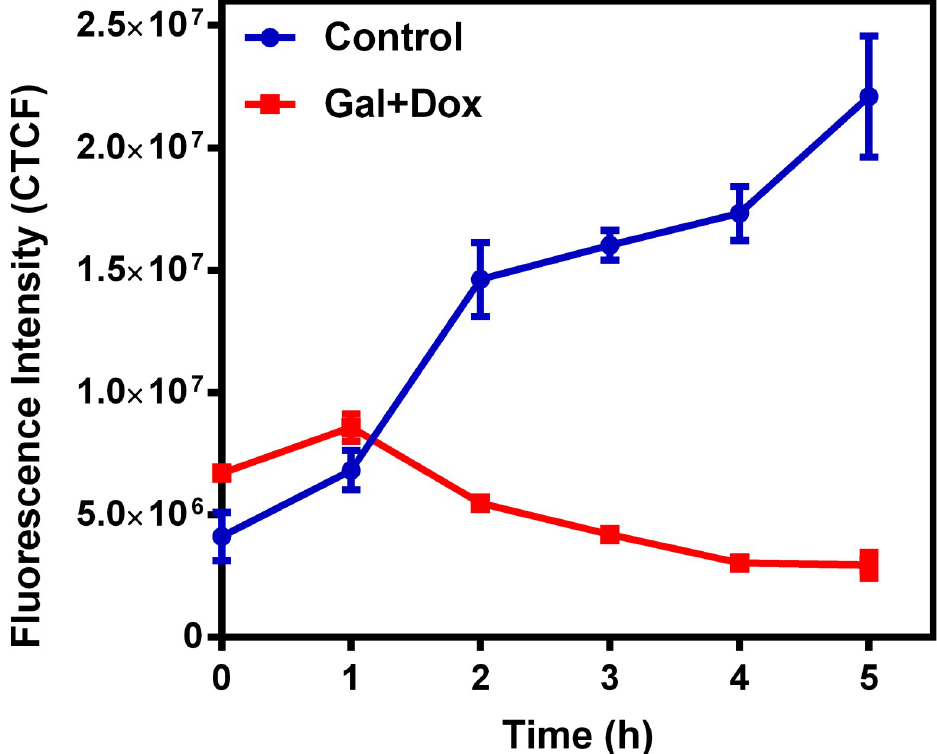
Fig 7. DOX induced cardiomyopathy in rat cardiomyocytes cells. H9c2 cells were treated with DOX (0 and 10 μ g/ mL) for 0–5 h and uptake of Galmydar (20 μ M, 60 min) was determined using fluorescence imaging. Corrected Total Cell Fluorescence (CTCF) = Integrated Density–(Area of selected cell × Mean fluorescence of background readings); (mean ± SEM, χ r2 (1, N = 35) = 2.88, p = 0.09, Friedman’s chi-square).